Question: Give a one-sentence summary of this figure.
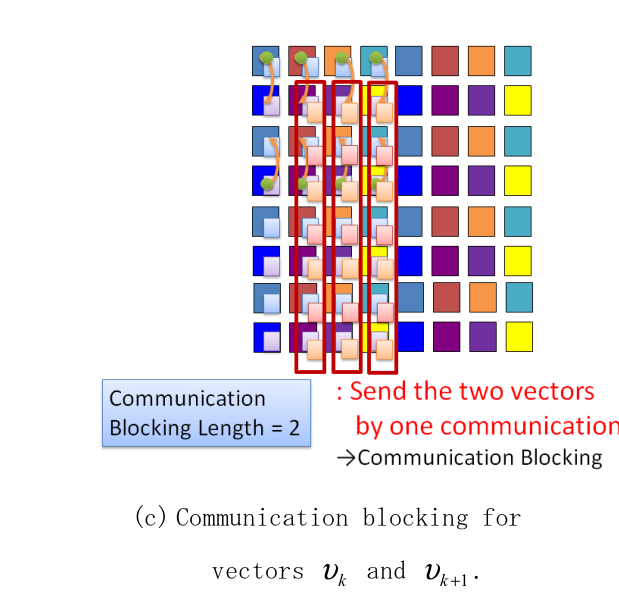
Answer: A snapshot of communication blocking for HIT. Process